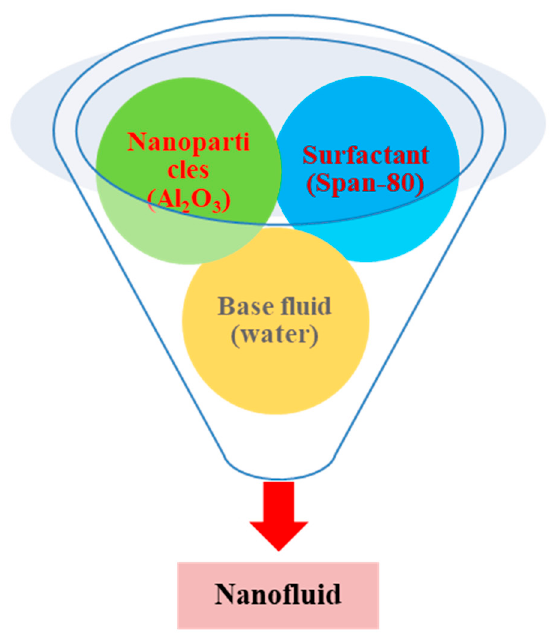
Figure 3. Representation of typical nanofluid preparation.